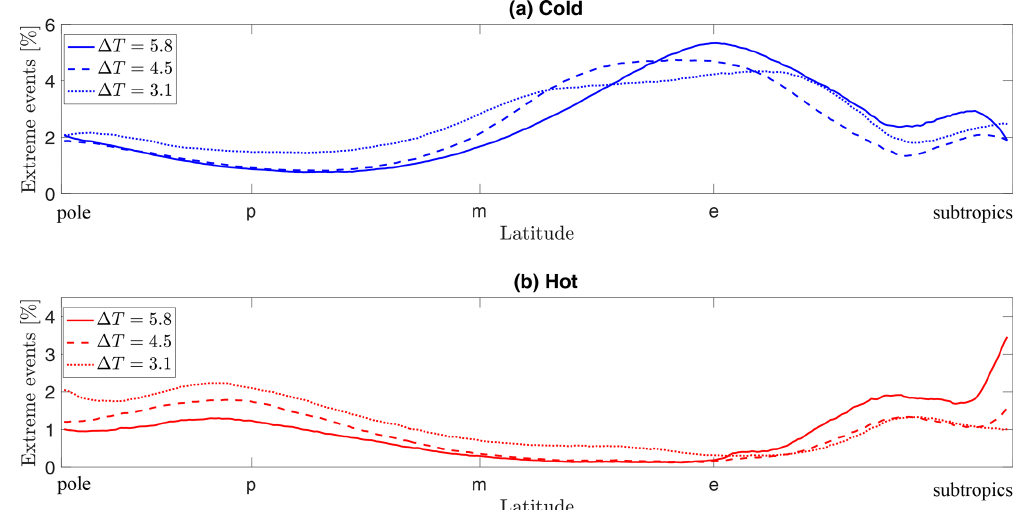
Figure 10. Number of extreme events (in percent) as a function of latitude in the experiment. Panel (a) depicts the cold events, whilst panel (b) depicts the hot events. The lines are solid for the experiment at (cid:49)T = 5 . 2K, dashed at (cid:49)T = 3 . 8K, and dotted at (cid:49)T = 3K. The labels p, m, and e indicate the latitudes at which the trends shown in Fig. 9 are taken (see Fig. 6 to visualise their